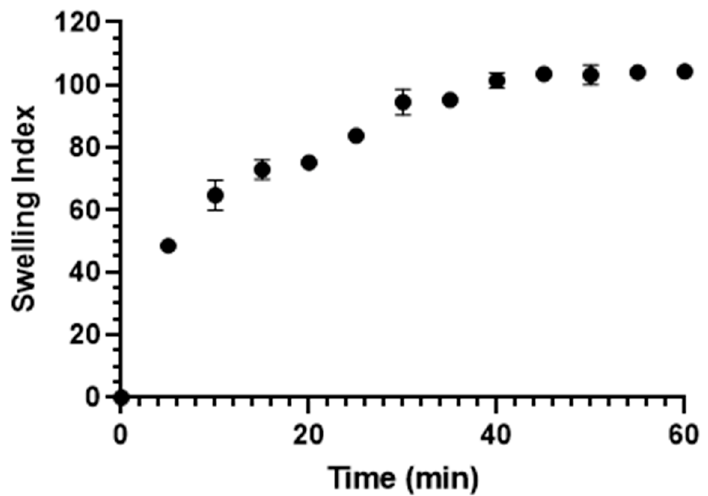
Figure 5. Swelling index as a function of time (min); mean ± SE ( n = 3).